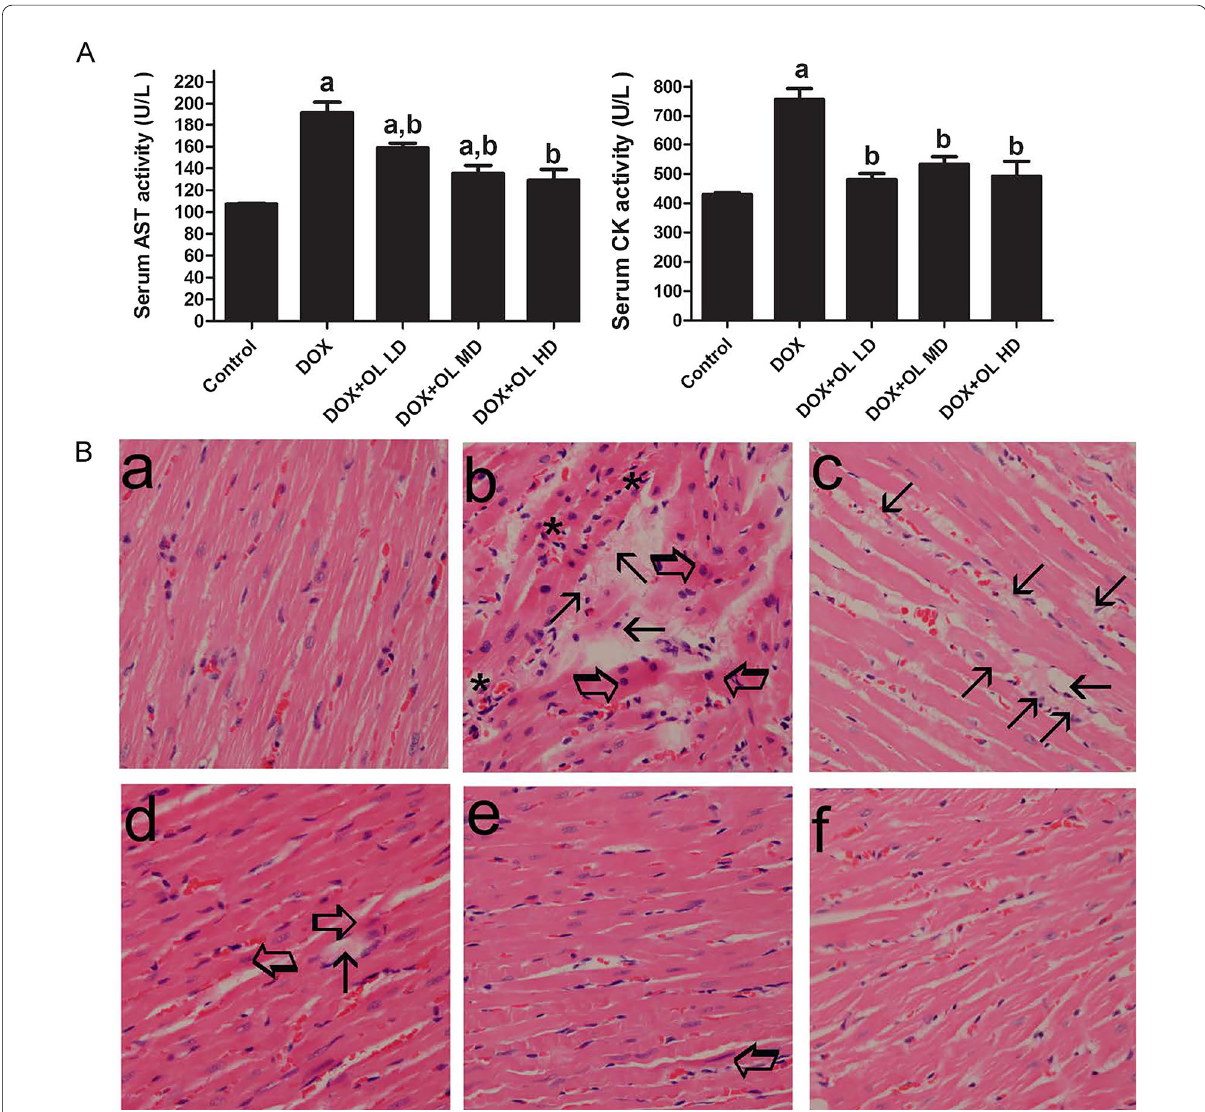
Fig. 1 Cardio protective effect of OL against DOX-induced cardiac damage, A serum cardiac injury markers: AST and CK activities in serum. Data are represented as mean S.E.M. of six rats of each of the groups. a P < 0.05 versus control; b P < 0.05 versus DOX. B Histopathological changes. ± Light micrographs of heart sections from control rats (a) showing normal heart architecture, heart sections from DOX groups (b & c) showing focal necrosis with eosinophilic cytoplasm and pyknotic nuclei (thick arrow) and degeneration of myocardial fibers (thin arrow), and inflammatory cell infiltration (*). In the micrographs from DOX LD of OL group (d) and DOX MD of OL group (e) showing some eosinophilic cytoplasm and + + pyknotic nuclei and degeneration of myocardial fibers. 400 ×